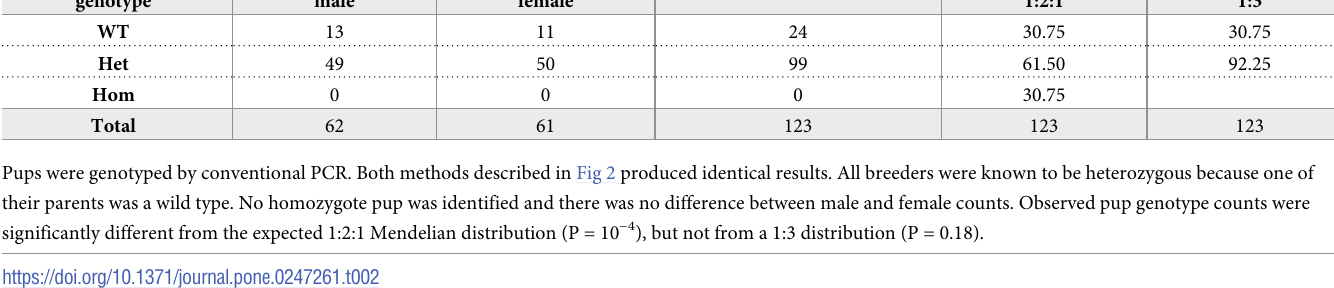
Table 2. Het x Het crosses of initial floxed Poldip2 mice fail to produce homozygotes.